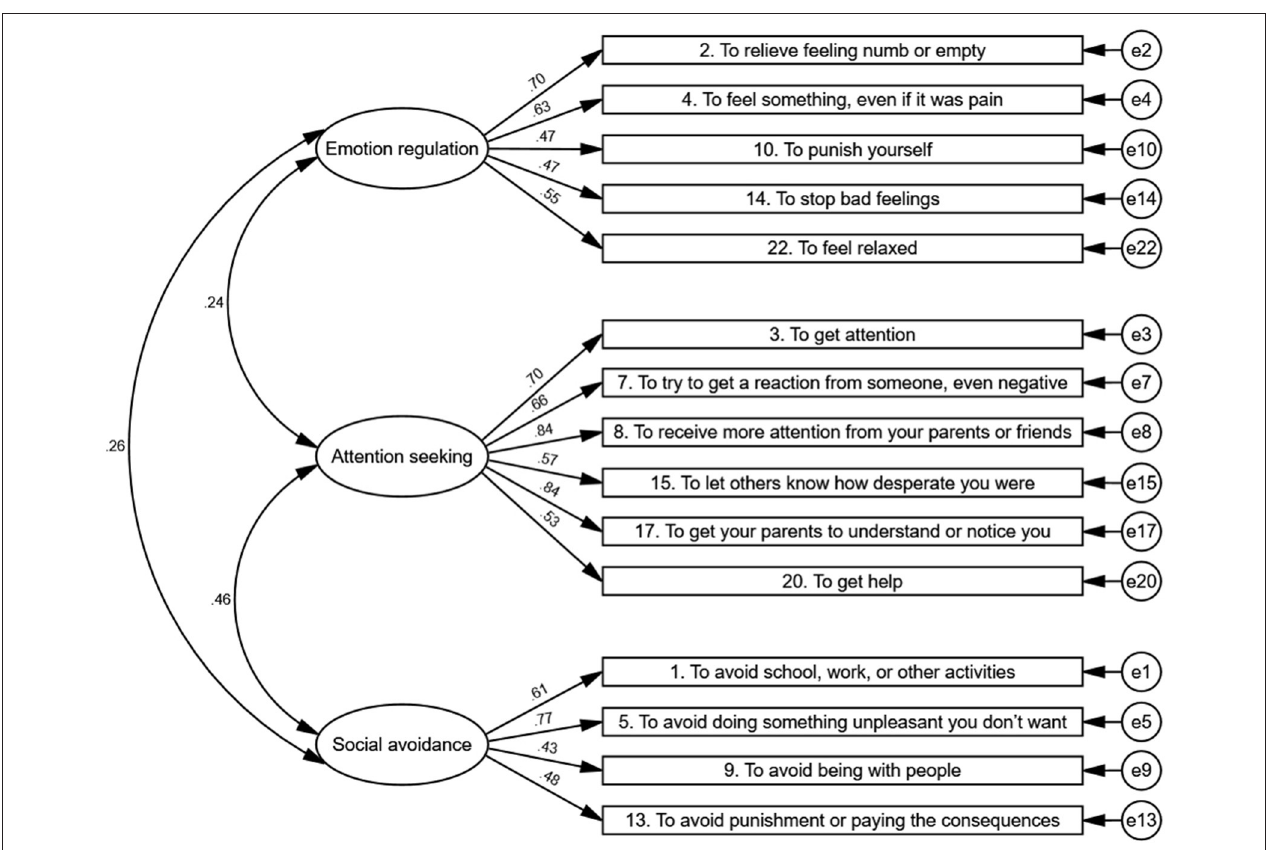
FIGURE 2 | Confirmatory factor analysis.